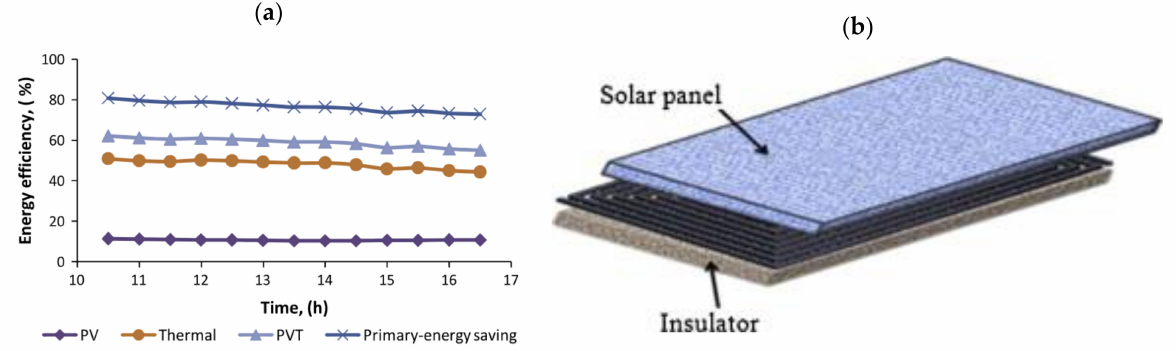
Figure 26. ( a ) Variation of efficiencies over the time at a mass flow rate of 0.027 kg/s; ( b ) spiral flow absorber (reprinted from [123], with permission from